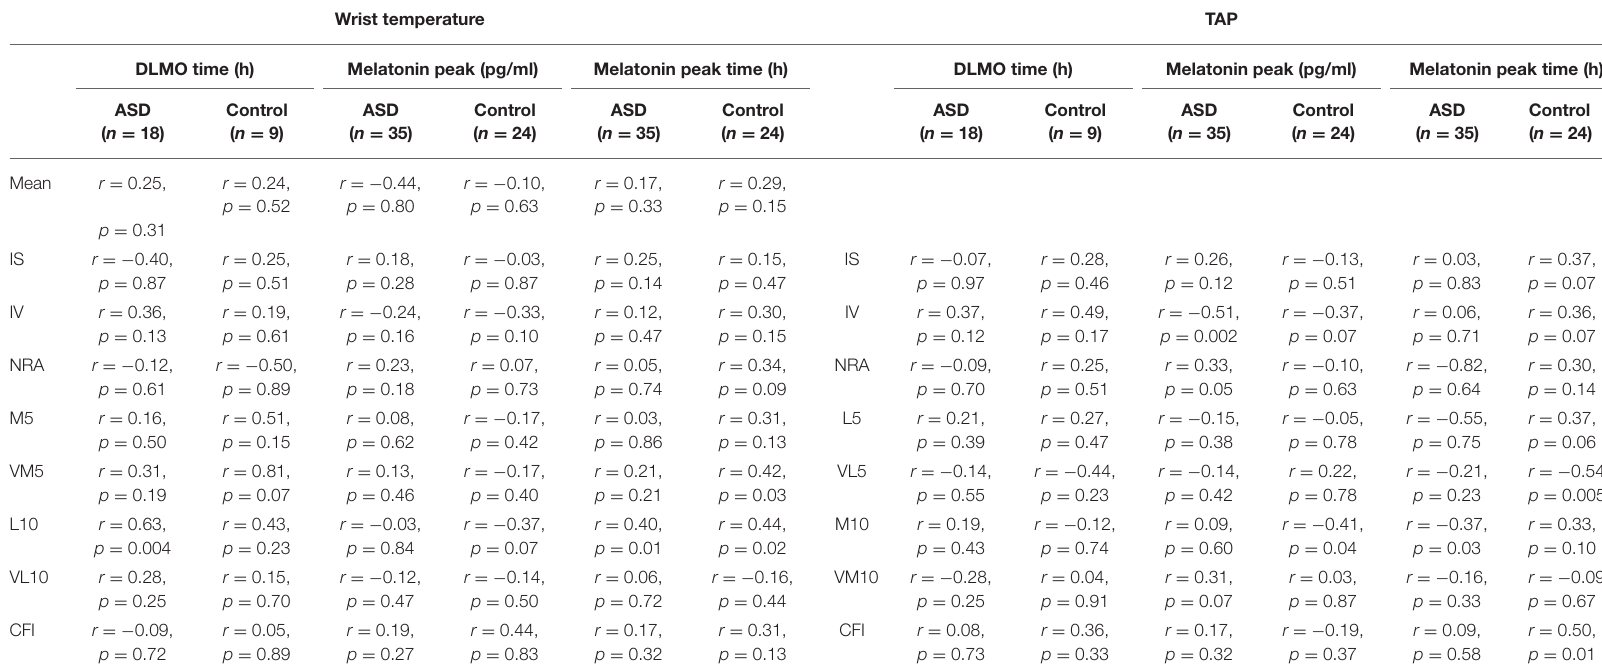
TABLE 5 | Melatonin and circadian parameters (temperature and